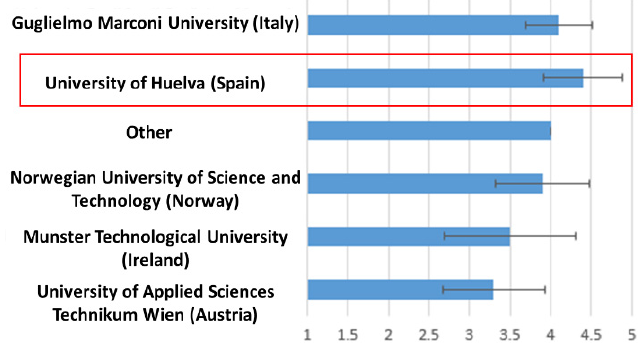
Figure 4. Satisfaction level with laboratory practices. Results from surveys of professors, students, and technical staff.